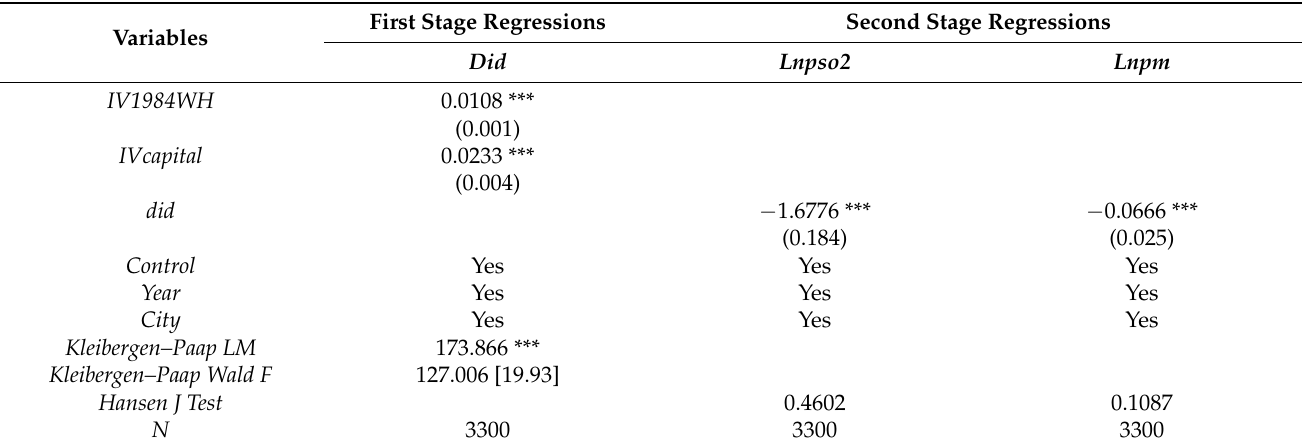
Table 5. Results of the test based on two-stage least